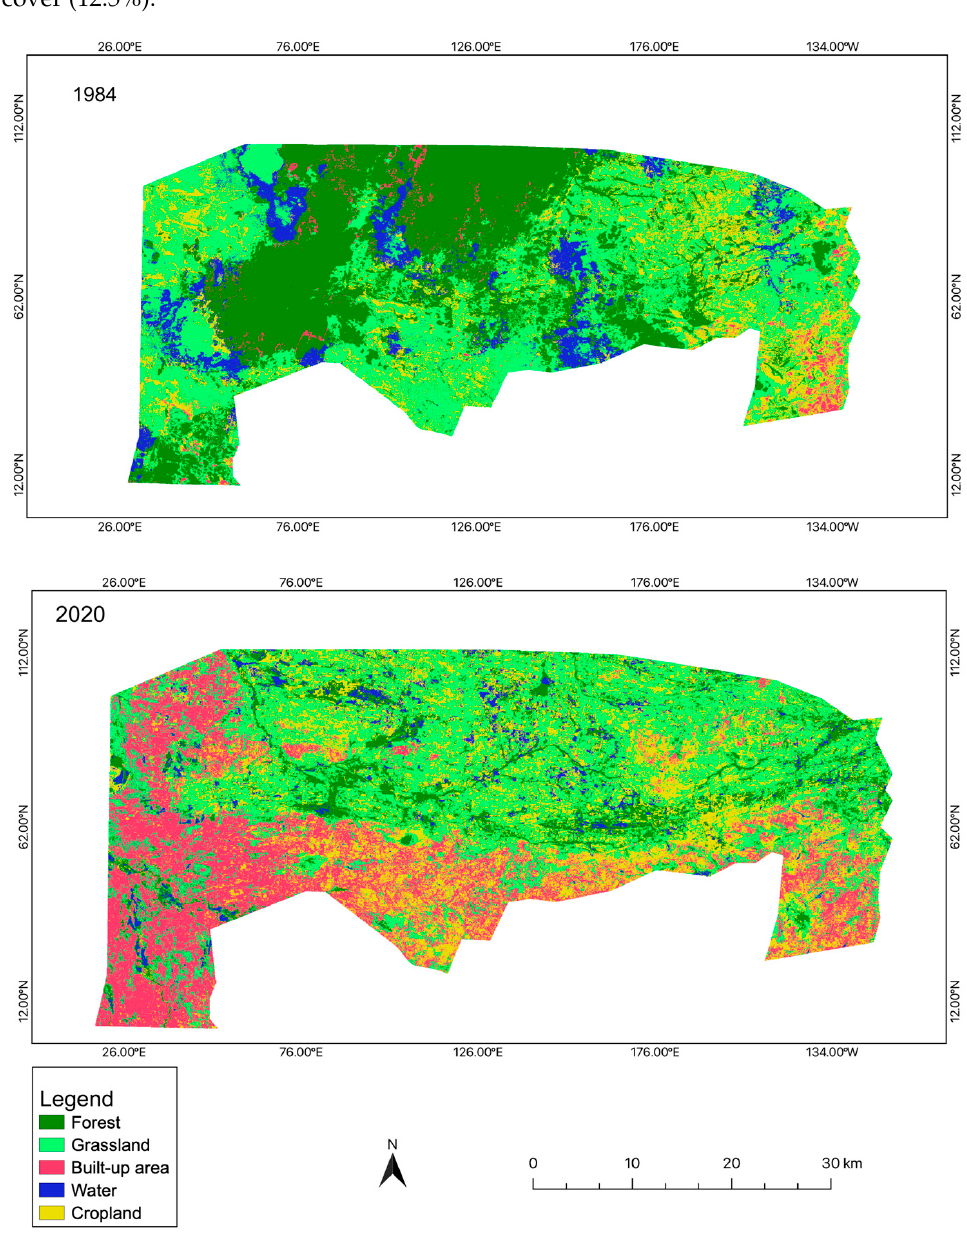
Figure 3. Land-cover maps for 1984 and 2020 for Chief Chikanta’s area, Kalomo District, used to discuss drivers of landscape change in MSPs.